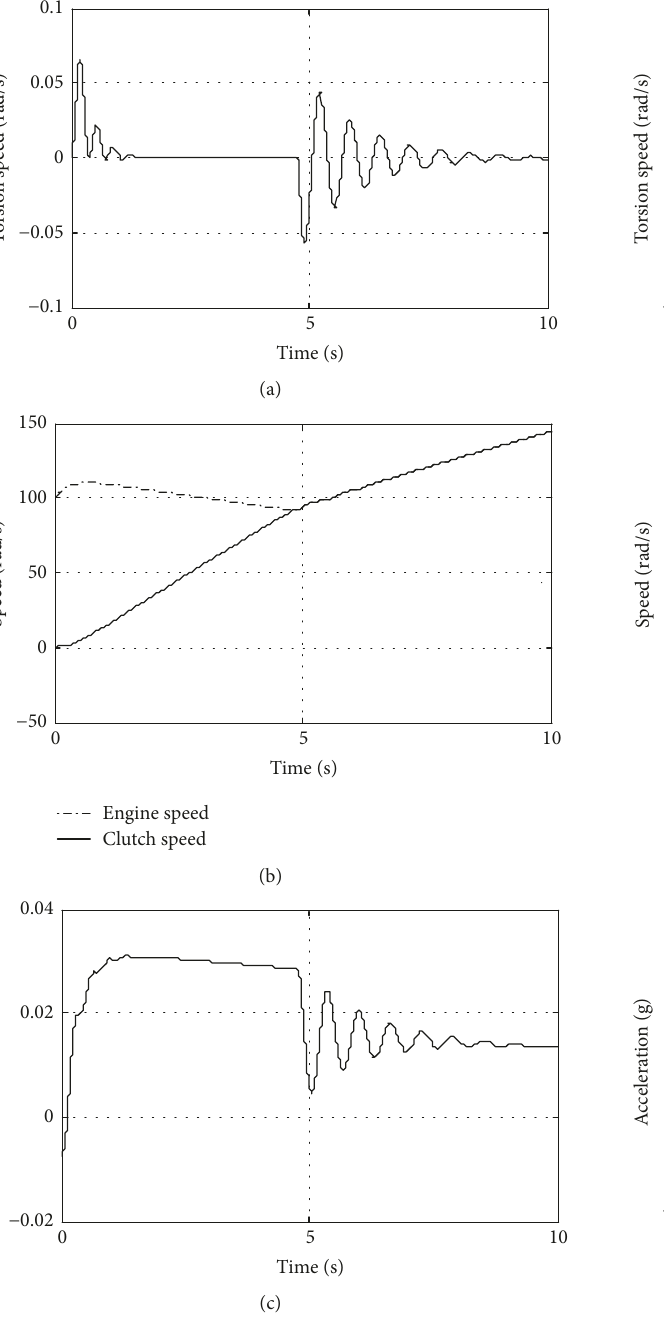
Figure 9: M2 maneuver simulation